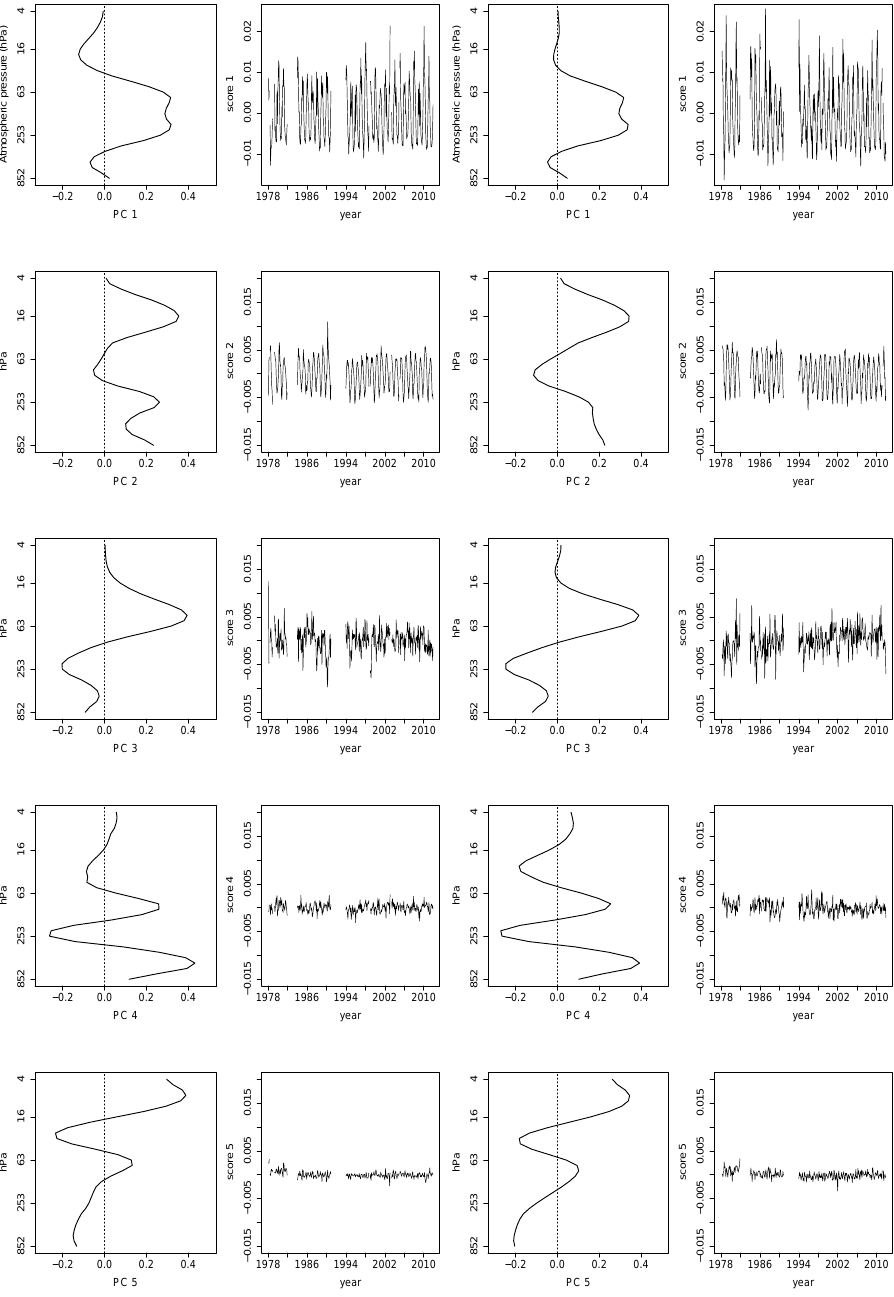
Fig. 3. The estimated five PC curves as a function of altitude in hPa, and the corresponding PC scores of monthly Umkehr ozone profiles from 1978 to 2011. First and third columns are the PC curves for Boulder and Arosa, respectively. Second and fourth columns represent the first five time series PC scores associated with the PC curve on their left-hand side. In the plots of the PC scores, two volcanic periods (1982-1983 and 1991-1993) are omitted.